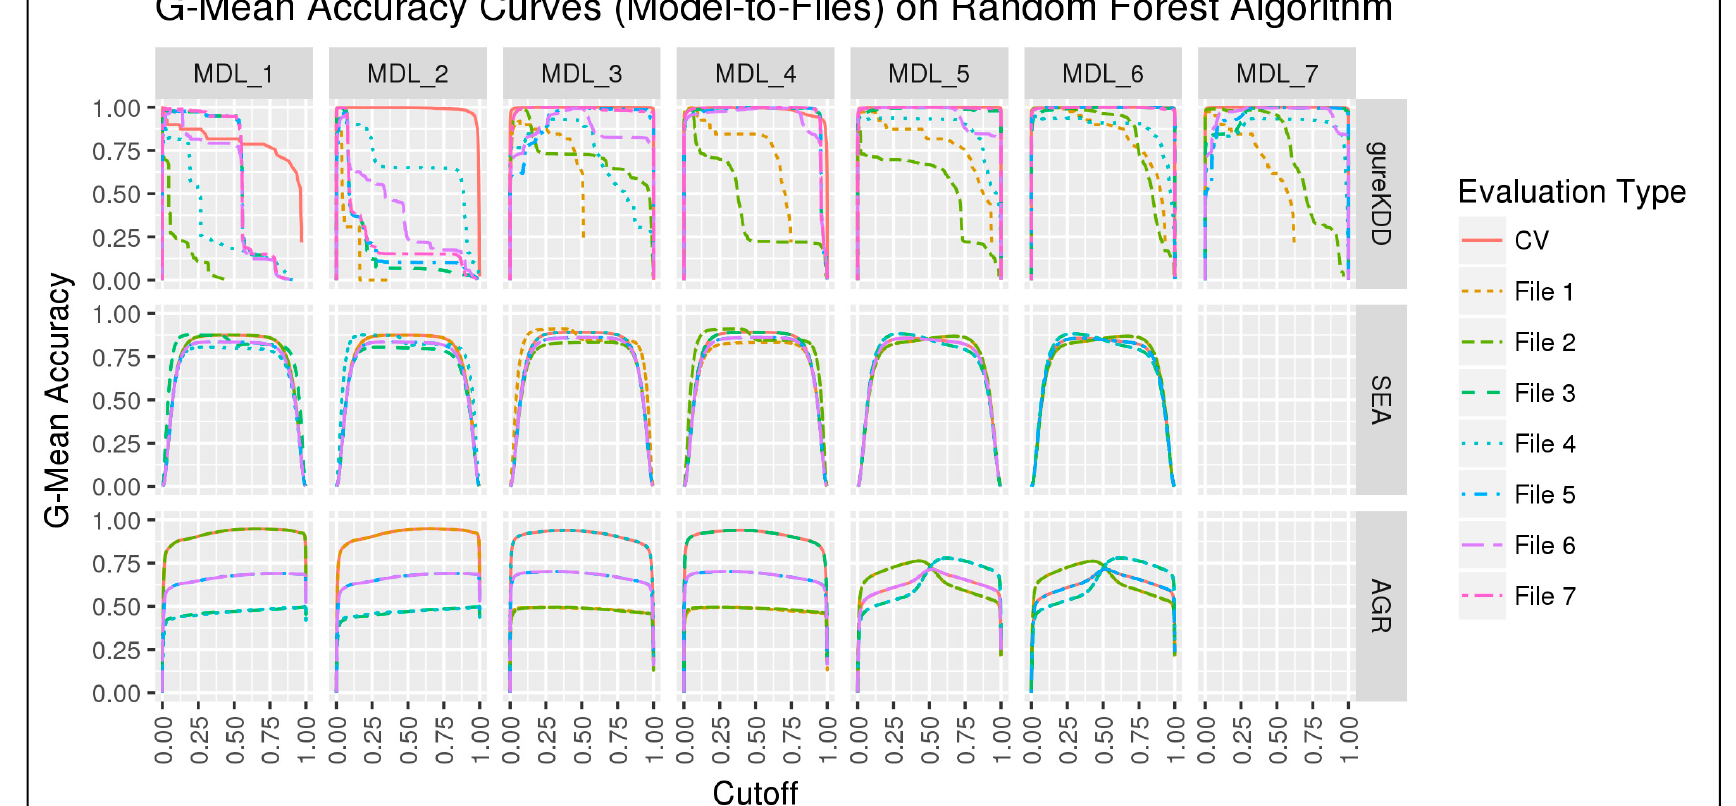
Figure A2. The gAcc curves for Random Forest algorithm (see Table A2).